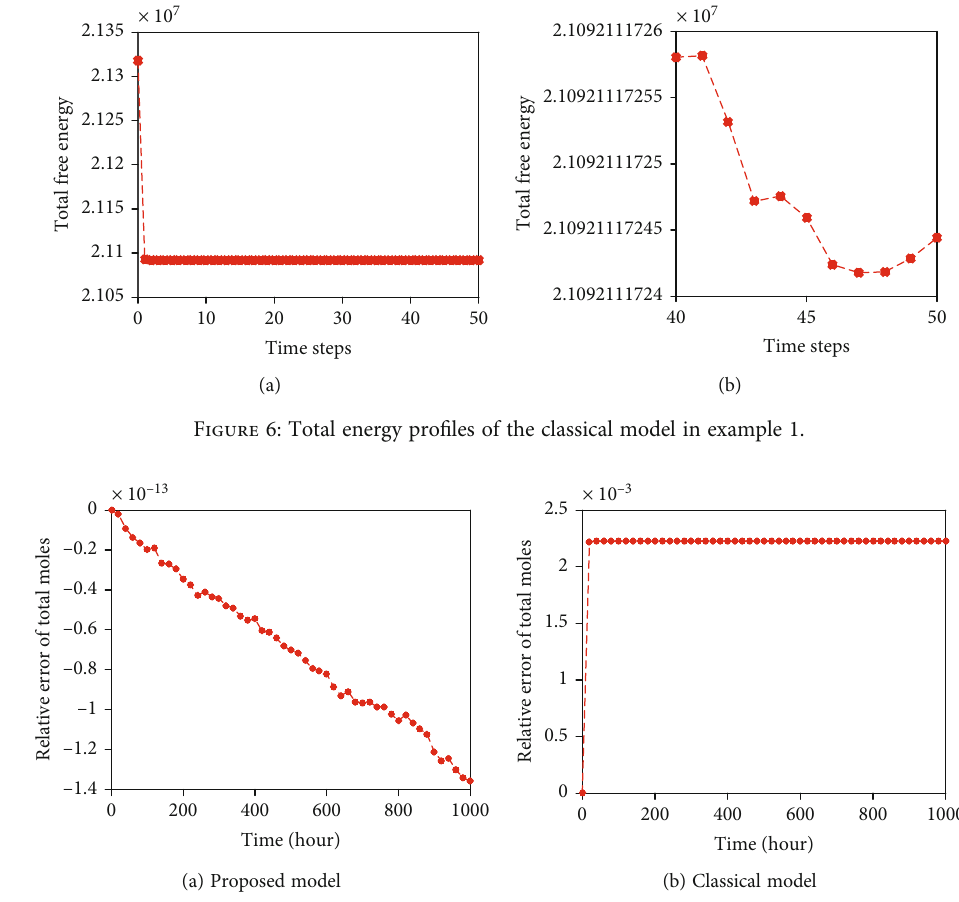
Figure 7: Comparison of total moles conservation in example 1.